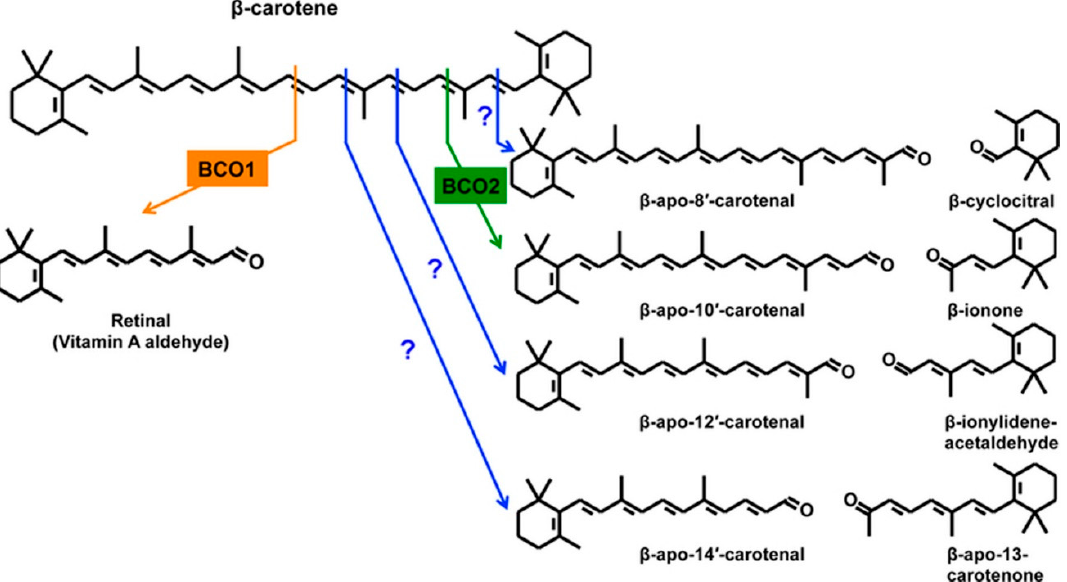
Figure 1. Central and eccentric cleavages of β -carotene. Oxidative cleavage of β -carotene at the 15, 15 ′ double bond is catalyzed by the enzyme β -carotene 15, 15 ′ -dioxygenase 1 (BCO1) and yields two molecules of retinal ( β -apo-15-carotenal). Cleavage at other double bonds leads to the formation of β -apocarotenals and β -apocarotenones. The cleavage at the 9 ′ , 10 ′ double bond is catalyzed by β -carotene 9 ′ 10 ′ -dioxygenase 2 (BCO2) and yields β -apo-10 ′ -carotenal and β -ionone. Eccentric cleavage at other double bonds occurs nonenzymatically or may be enzyme-catalyzed. In cells, the β -apocarotenals can be reduced to the corresponding β -apocarotenols by aldehyde reductases and/or alcohol dehydrogenases. The β -apocarotenals can also be oxidized to the corresponding β -apocarotenoic acids by aldehyde dehydrogenases. (Figure 1 from [4] with permission).